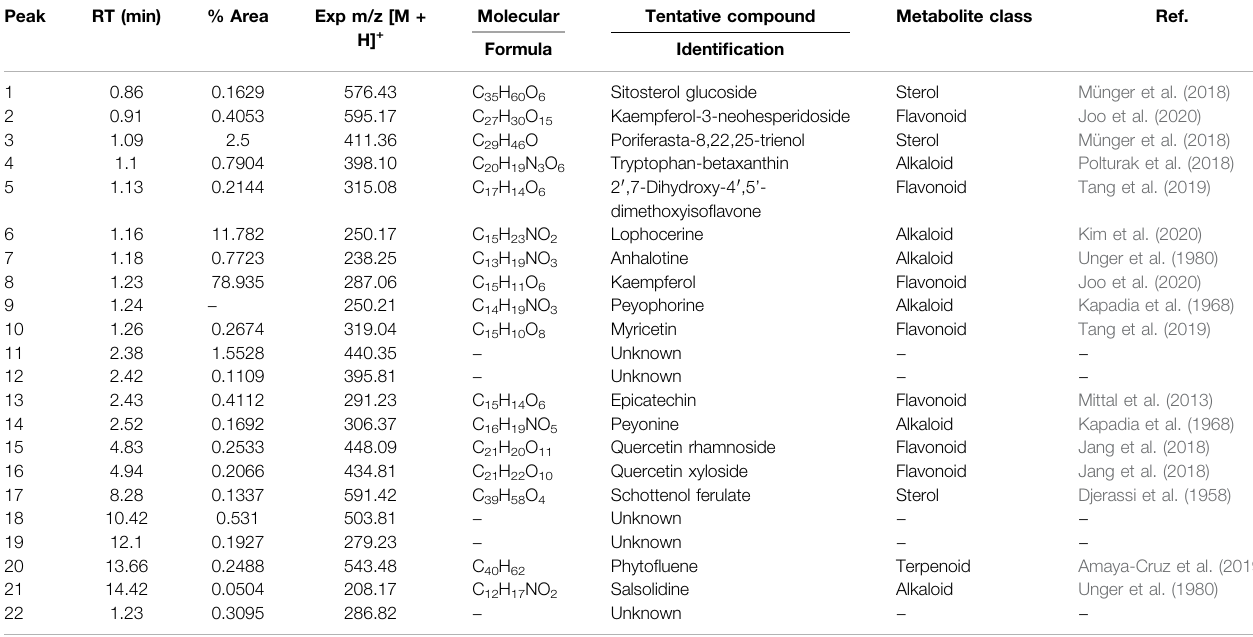
TABLE 4 | Secondary metabolites present in the ethanolic extract of Lophocereus schottii . Peak RT